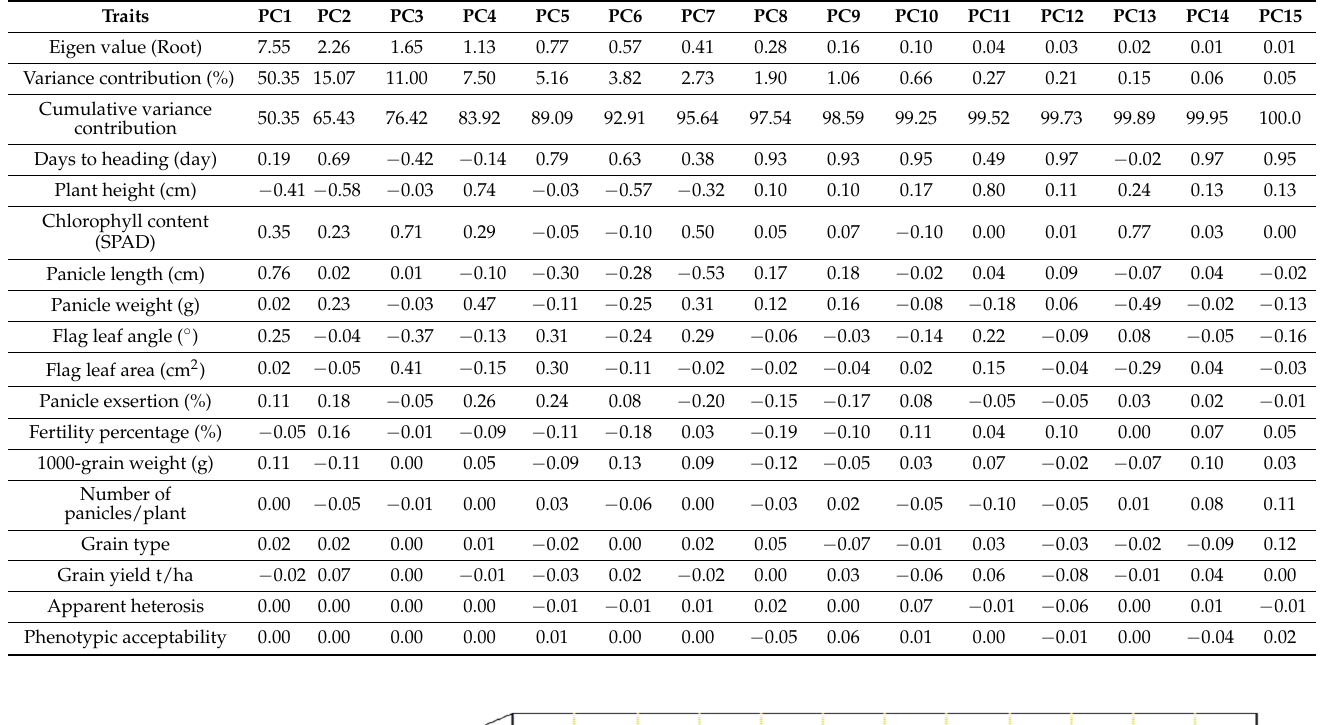
Table 6. Eigen values, % variance, and cumulative % variance of 15 morphological traits for princi- pal components.